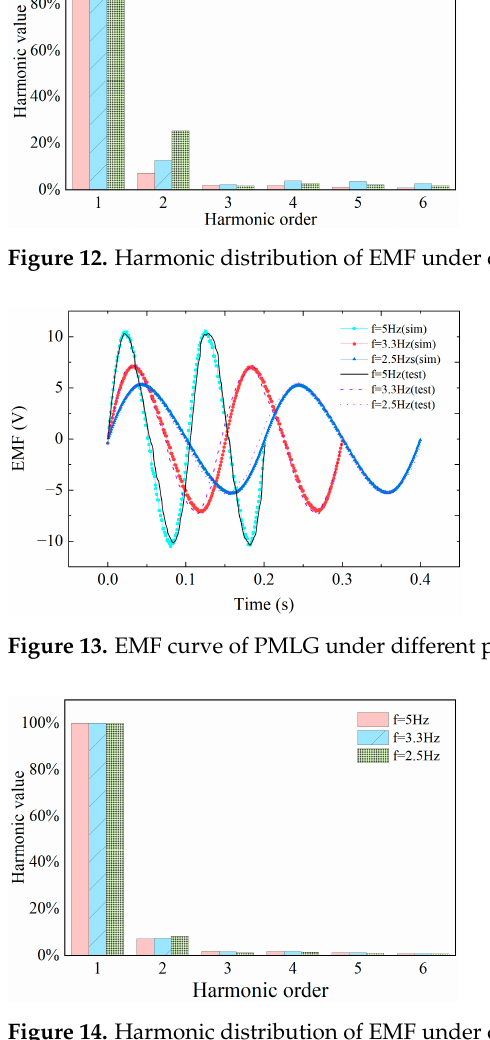
Figure 14. Harmonic distribution of EMF under different periods.